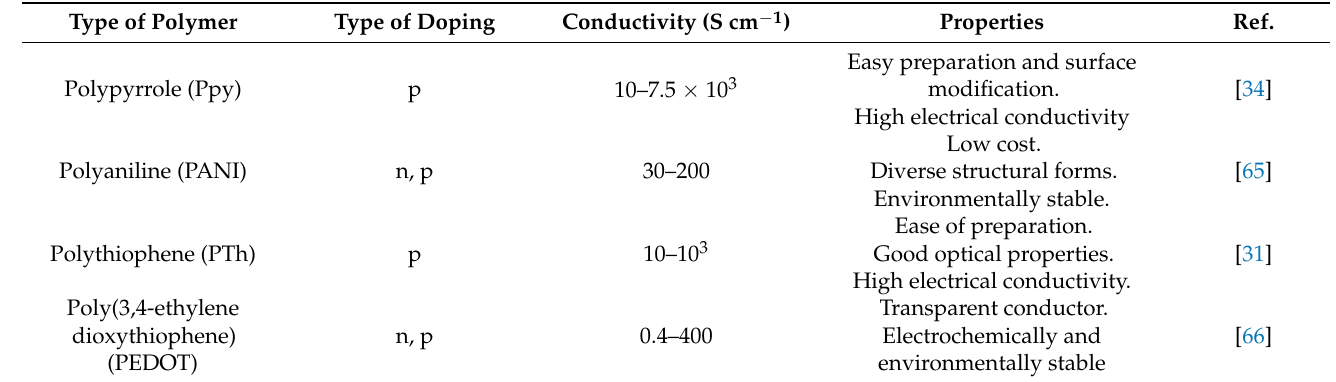
Table 2. Brief overview of conductivity and other properties of commonly conjugated CPs used in the field of